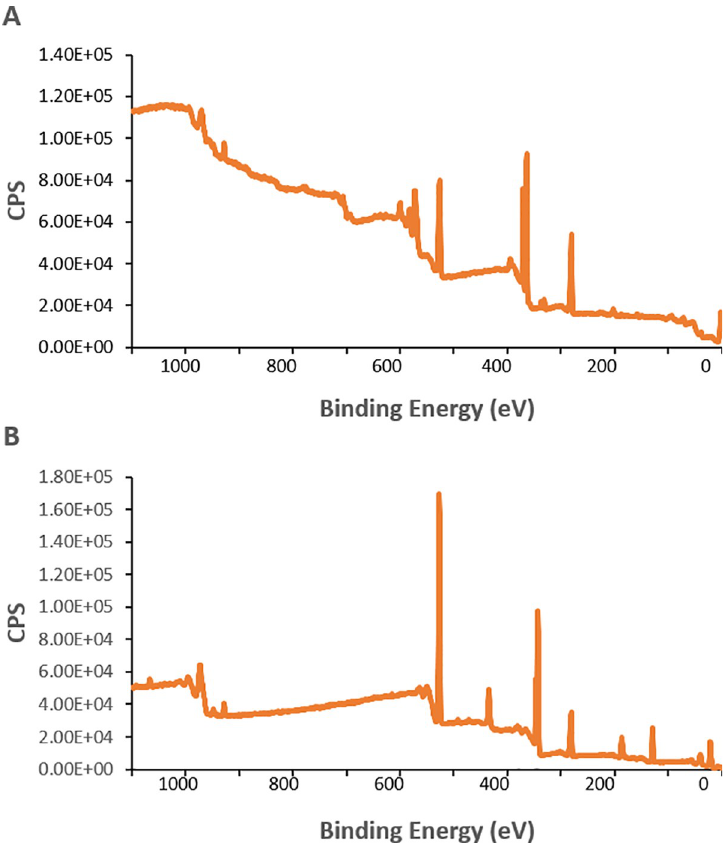
Fig 2. XPS wide scan spectrum for each specific surface: (A) metallic brackets, pre-treated with distilled water, and (B) HA discs, pre-treated with distilled water. https://doi.org/10.1371/journal.pone.0254909.g002 (128 eV) as major components. Atoms % of calcium and phosphorus ratio (Ca/P ratio) was calculated as 1.45. The mean and standard derivation of the atomic concentration in both groups was presented in Table 1.